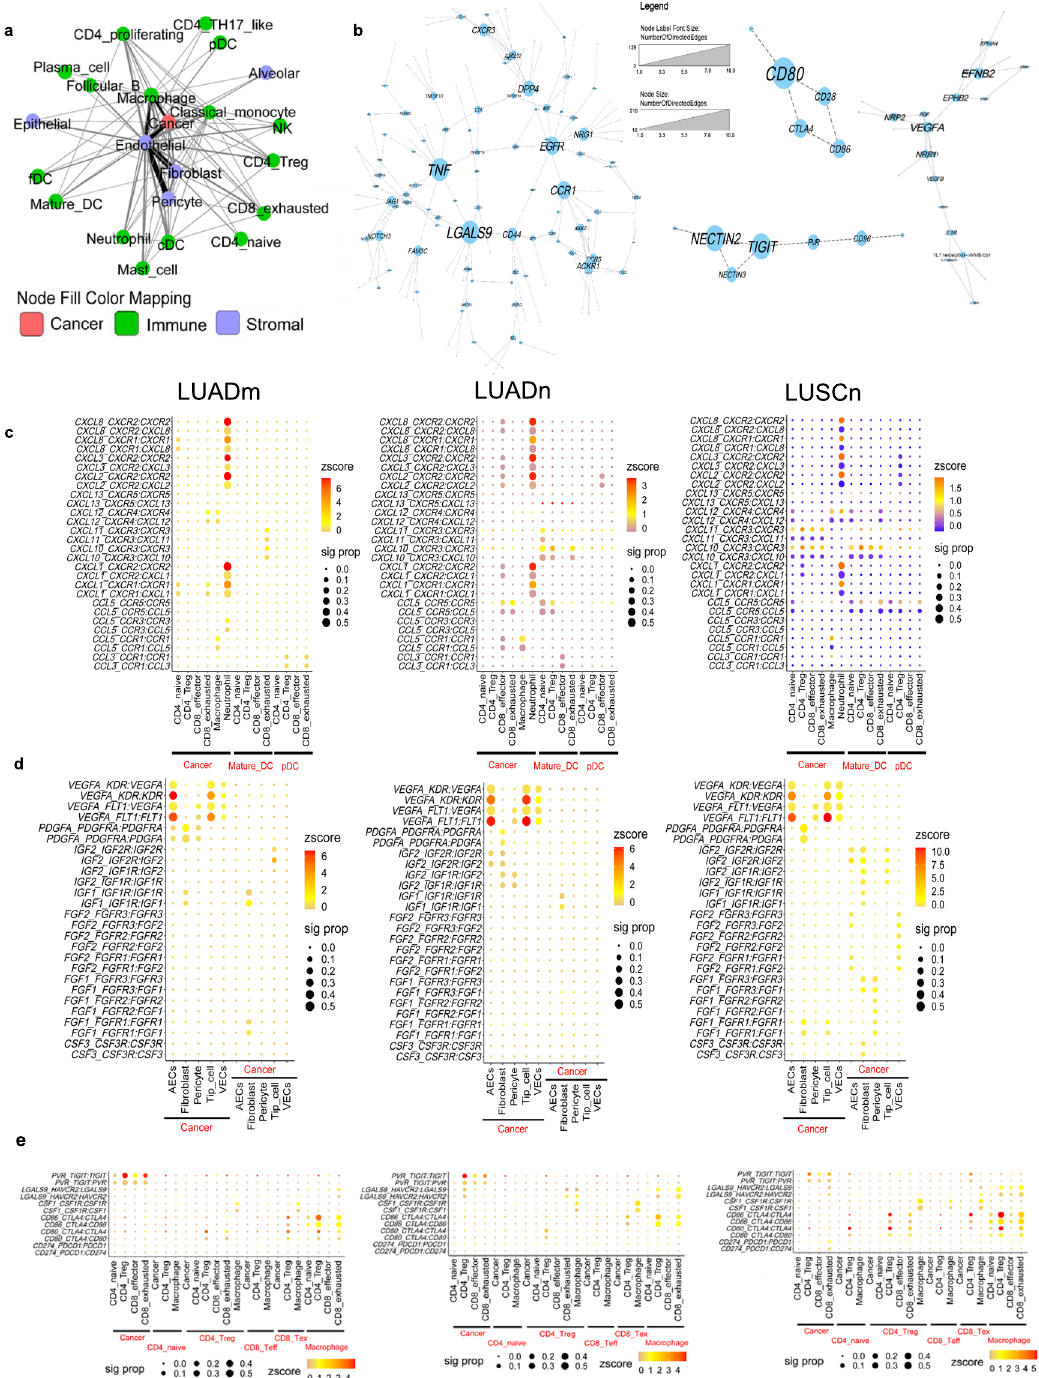
Fig. 6 Cell and gene interaction networks. a The cellular interaction network among cell types of NSCLC patients. The line width and color were proportional to numbers of interactions between cell types. b Interacting molecular networks. Within each connected network, node (gene) sizes were proportional to the number of neighbors (interacting genes) of each node. Heatmaps shown selected interacting pairs for selected cell types in LUADm, LUADn, and LUSCn groups. Z-scores of expression levels were represented by color, and dot size displayed the proportion of patients who have signi fi cant interaction for the given ligand-receptor pair. c chemokine and chemokine receptors between cancer cells, T cells and DCs. d selected growth factors between cancer cells and stromal cells. e selected checkpoints between cancer cells, macrophages, and T